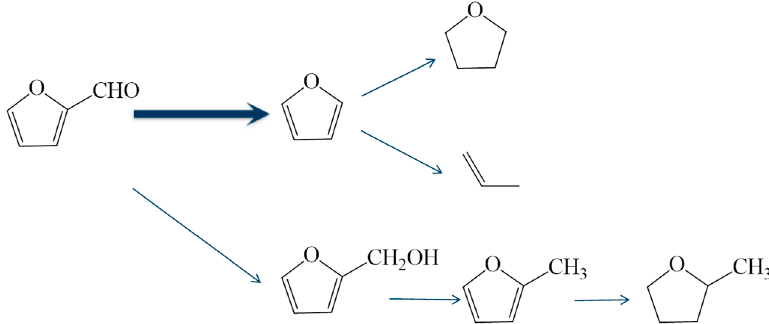
Scheme 1. Reaction pathway of furfural conversion over the 1%Pt/SBA-15 catalyst.